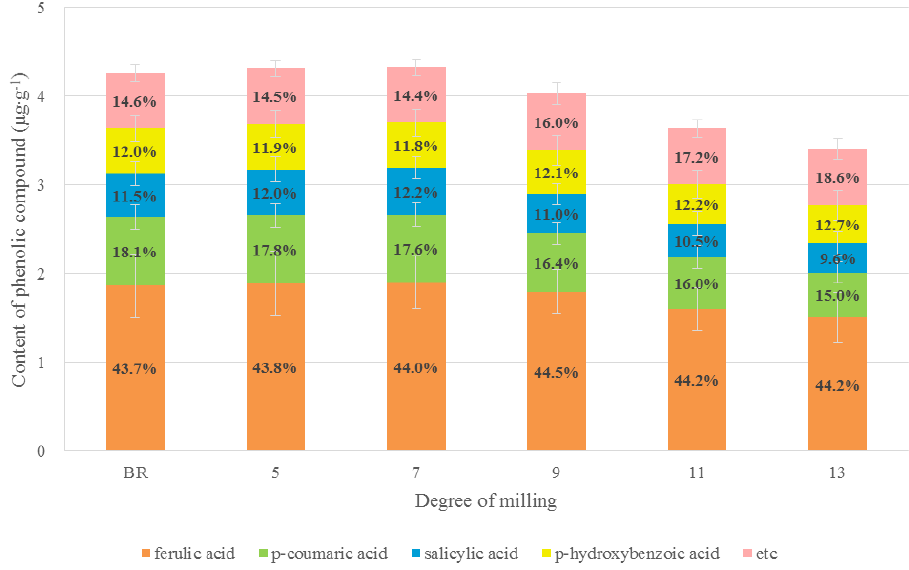
Figure 4. Comparison and variation of phenolic compounds in rice grains according to the DOM.